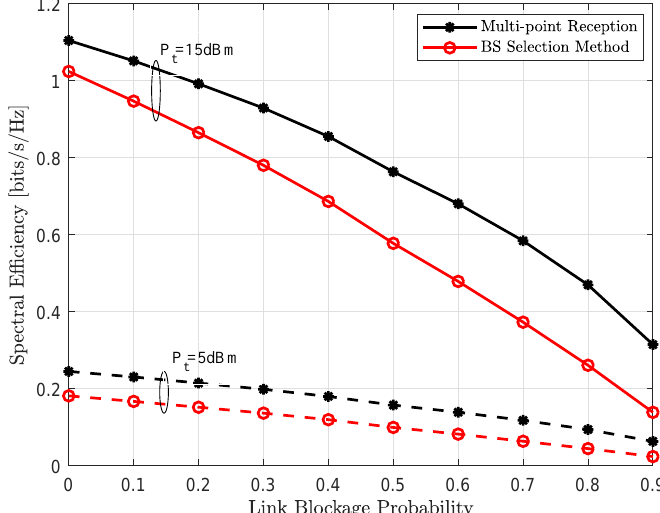
Figure 8. Achievable spectral efficiency assuming exact user location as a function of increasing link blockage probability P b for the uplink transmit power P t of P t = 5 dBm (dashed line) and P t = 15 dBm (solid